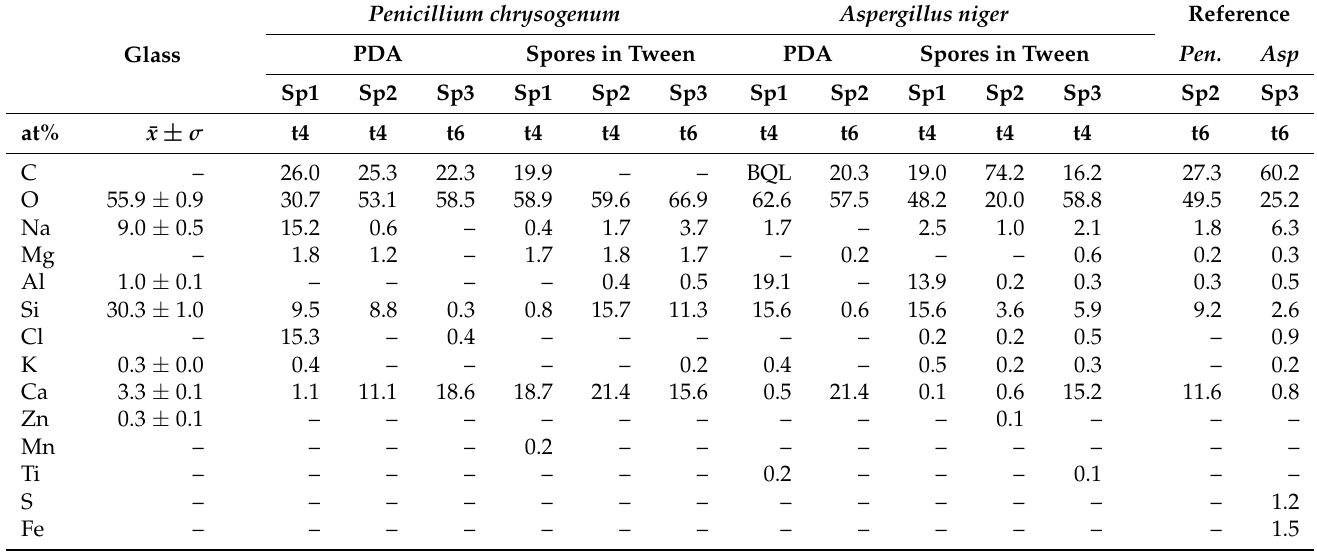
Table 2. Elemental composition (atomic %, at%) on the glass surface after 4 and 6 months inoculation with Penicillium chrysogenum and Aspergillus niger –spectra presented in Figure 4. Mean values correspond to the average of 3 samples analysed prior to inoculation. Legend: Sp = spot or area of SEM analysis where the EDS results were retrieved (see Figure 4); BQL = below quantification limit; ‘–’ = not present.